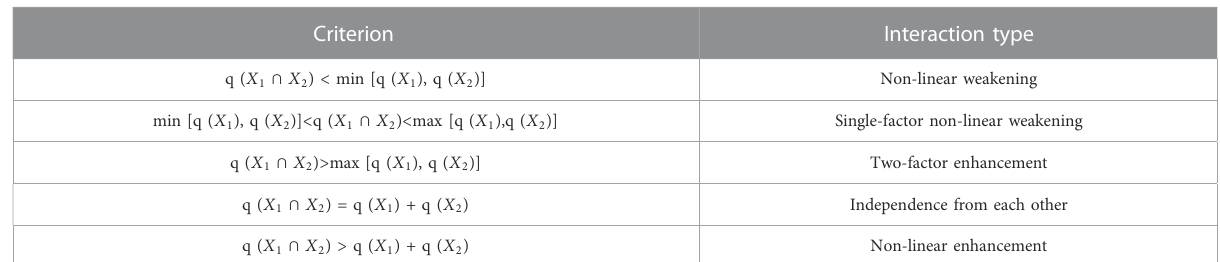
(Figure 2). The area of mobile dunes decreased signi fi cantly over this period, while the areas of fi xed dunes, semi fi xed dunes and cultivated land increased gradually during the study period. The